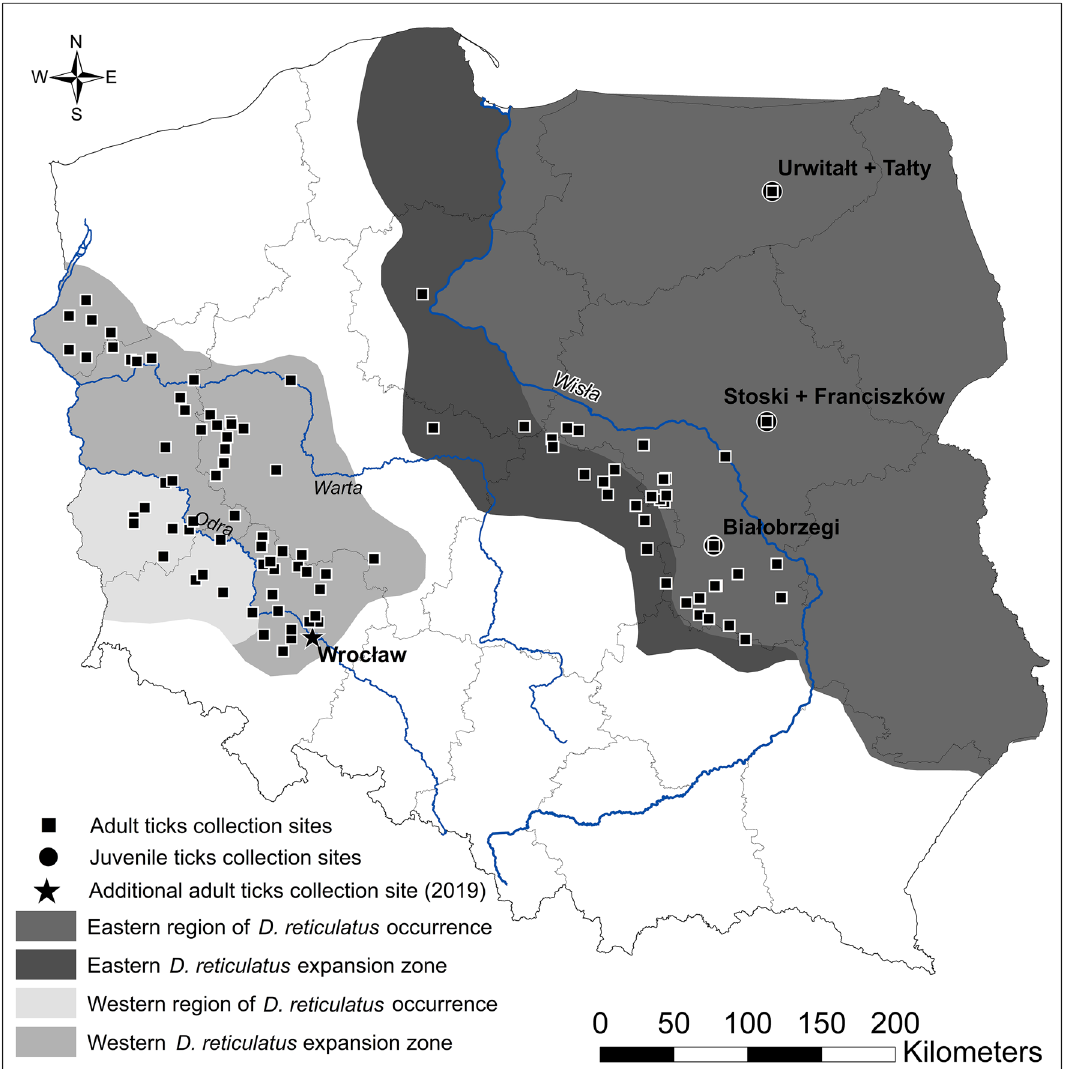
Figure 1. Map of endemic areas and expansion zones for adult questing Dermacentor reticulatus ticks (Dwużnik-Szarek et al. 2021) and sites of the collection of juvenile ticks. The map was designed using ArcGIS (ESRI) version 10.8.1 software (institutional licence purchased by the University of Warsaw, Warsaw, Poland). Briefly, each georeferenced location of tick collection (listed in Dwużnik-Szarek et al. 5 ) was projected as a point type .shp layer and then used as the raw data for spatial analyses. A radius buffer was calculated for each point, allowing to interpolate a range of occurrence of the tick. The base layer consisted of contour map of Poland: country borders and largest administrative units